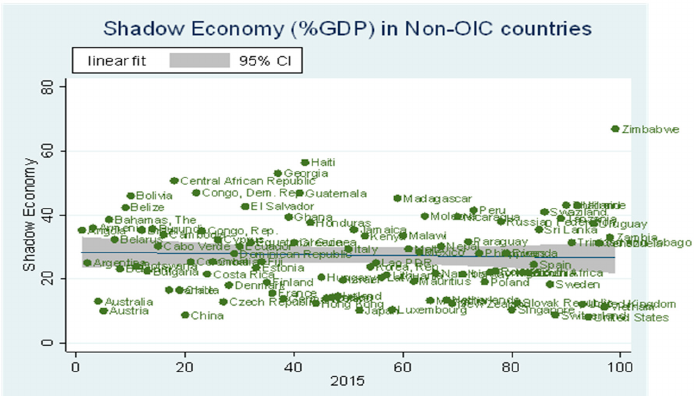
Figure 1. The average size of the shadow economy (% of GDP) in non-OIC. Source: authors’ estimations.